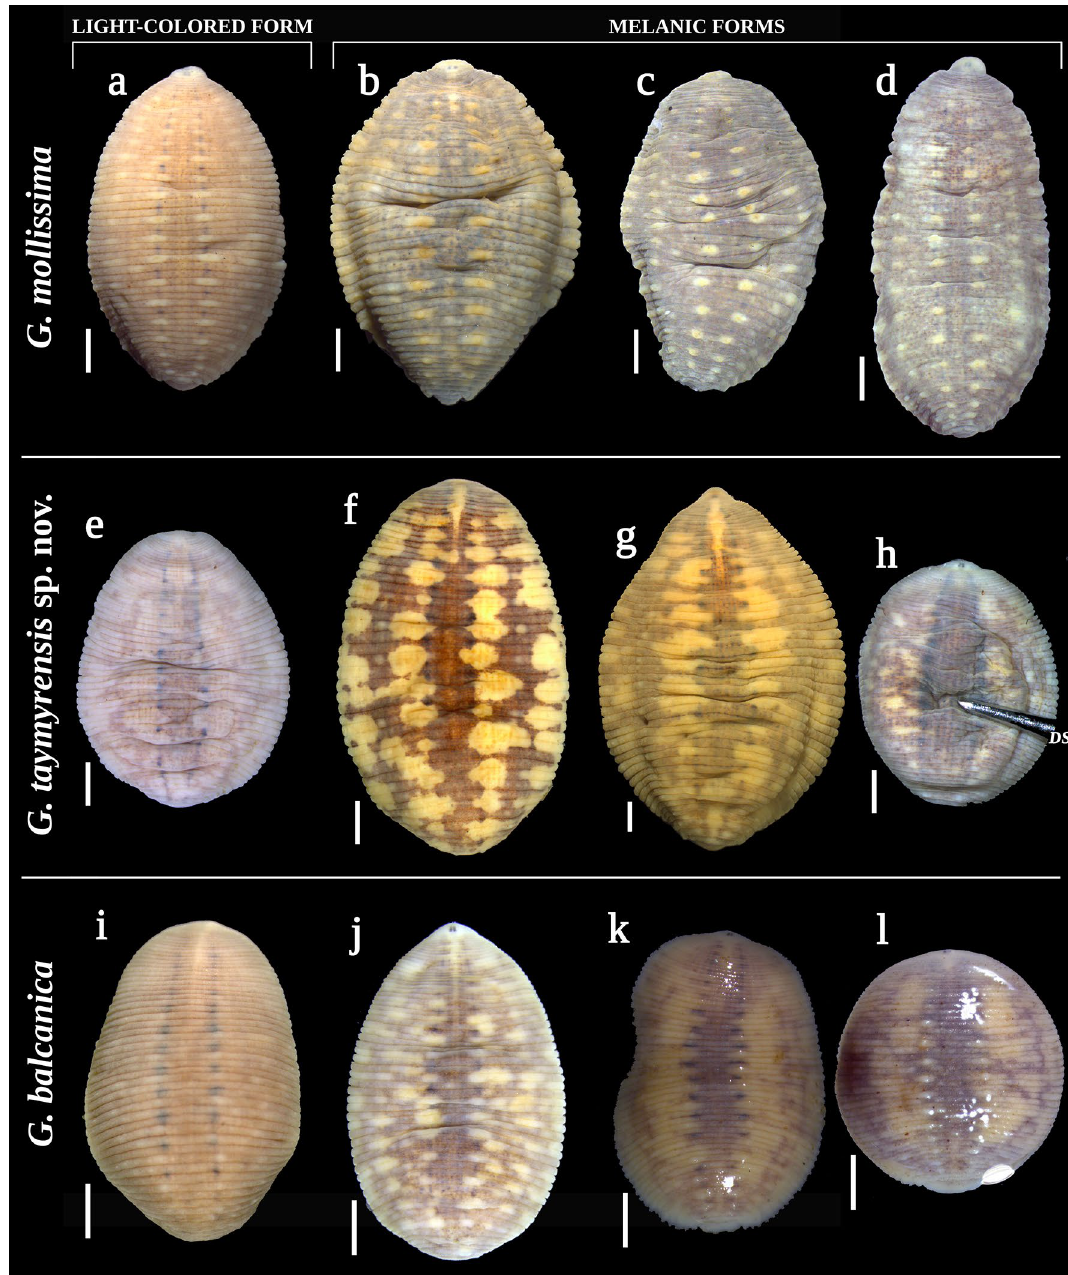
Figure 8. Examples of light-colored and melanic color forms of Glossiphonia spp. from the Eurasian Arctic (dorsal view). ( a – d ) G. mollissima , Chokurdakh, Arctic Yakutia: ( a ) RMBH Hir_0480_2 (light-colored form); ( b ) RMBH Hir_0478, ( c ) RMBH Hir_0483_2 and ( d ) RMBH Hir_0482_2 (‘darker’ melanic forms with reduced markings). ( e – h ) G. taymyrensis sp. nov.: ( e ) RMBH Hir_0264_3 (light-colored form); ( f ) RMBH Hir_0256_1, Dudinka, Taymyr Peninsula and ( g ) RMBH Hir_0488, Putorana Plateau (melanic forms: f. ‘maculosa’); and ( h ) RMBH Hir_0256_1, Dudinka, Taymyr Peninsula (‘darker’ melanic form with highly reduced markings). ( i–l ) G. balcanica : ( i ) RMBH Hir_0250 (light-colored form), Teriberka, Kola Peninsula; ( j ) RMBH Hir_0 457_4 (melanic form: f. ‘maculosa’), Sob’ railway station, Polar Urals; ( k ) RMBH Hir_0081_1 and ( l ) RMBH Hir_0083, Kharp, Polar Urals (‘darker’ melanic forms with reduced markings and darkened yellow areas). DS dissecting needle. Scale bars = 1.0 mm. Photos: Anna L. Klass and Tatyana A. Eliseeva; graphics: Ivan N.